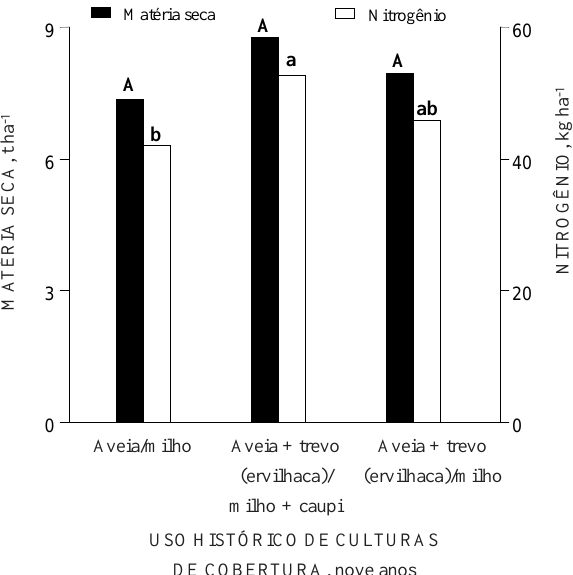
Figura 4. Produção de matéria seca e quantidade de nitrogênio absorvido pelo milho aos 95